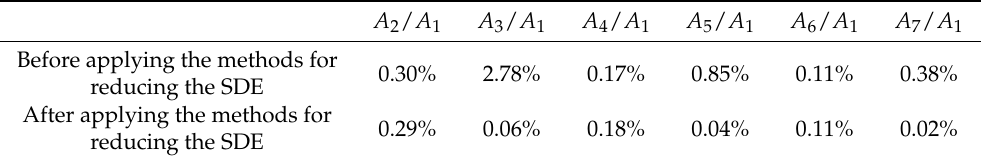
Table 1. Proportion of higher ‐ order harmonics.